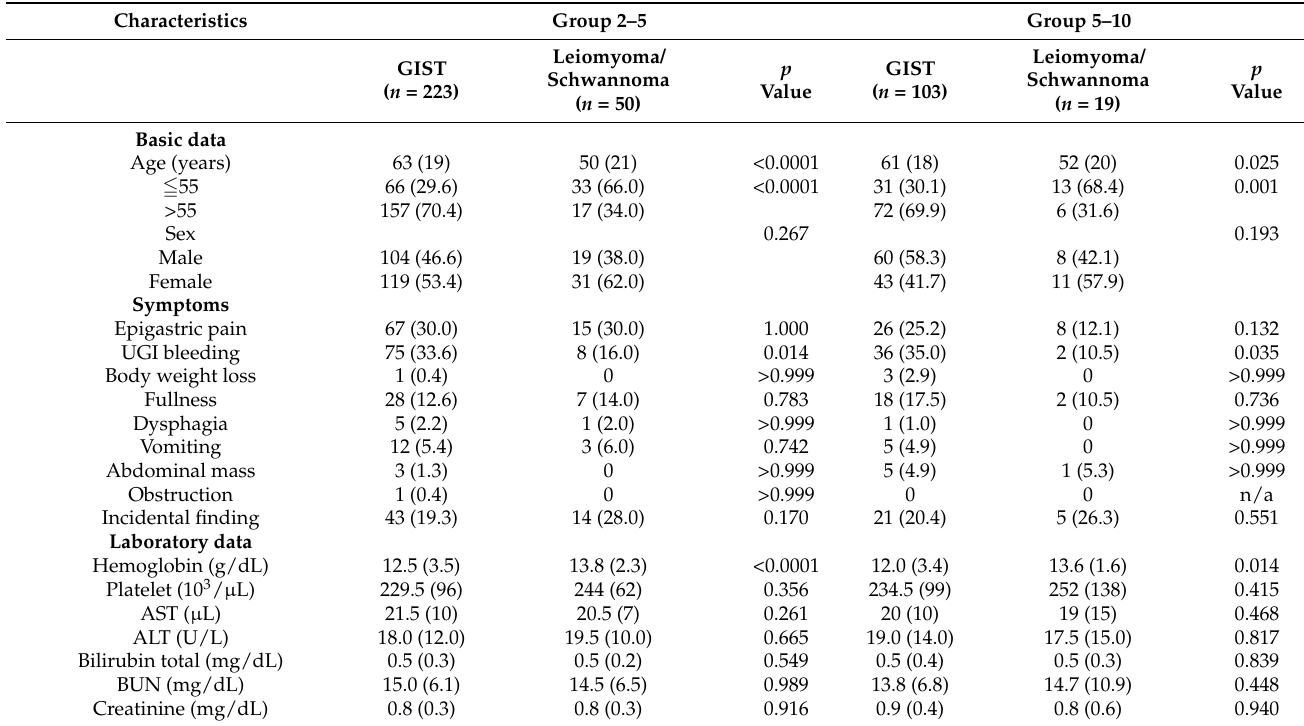
Table 1. Basic data, symptoms, and laboratory results.